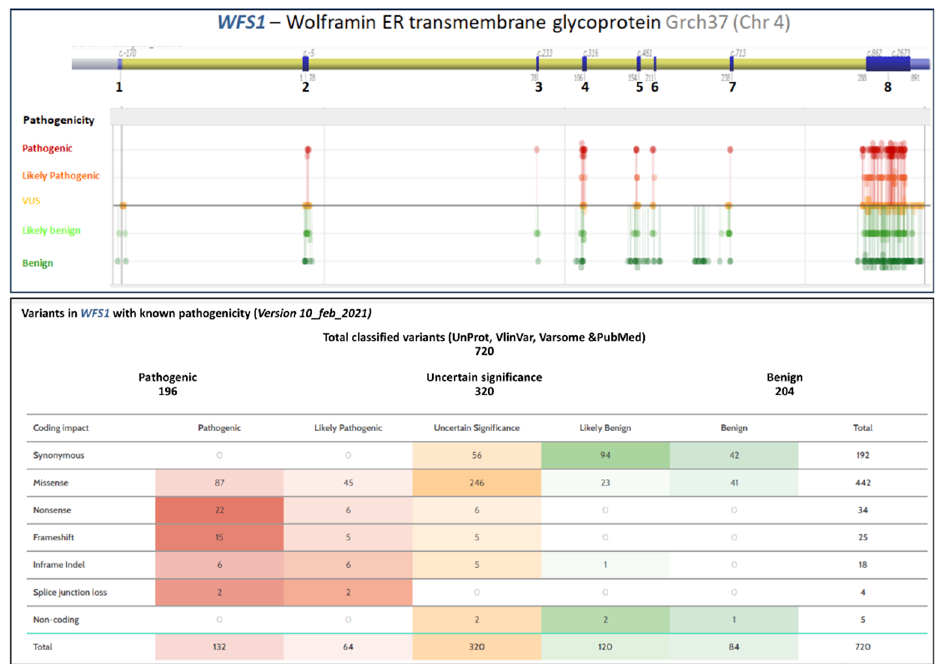
Figure 2. Genetic variant distribution in WFS1. Adapted from Alamut Visual version 2.15 (SO- PHiA GENETICS, Lausanne, Switzerland) and from VarSome: The Human Genomic Variant